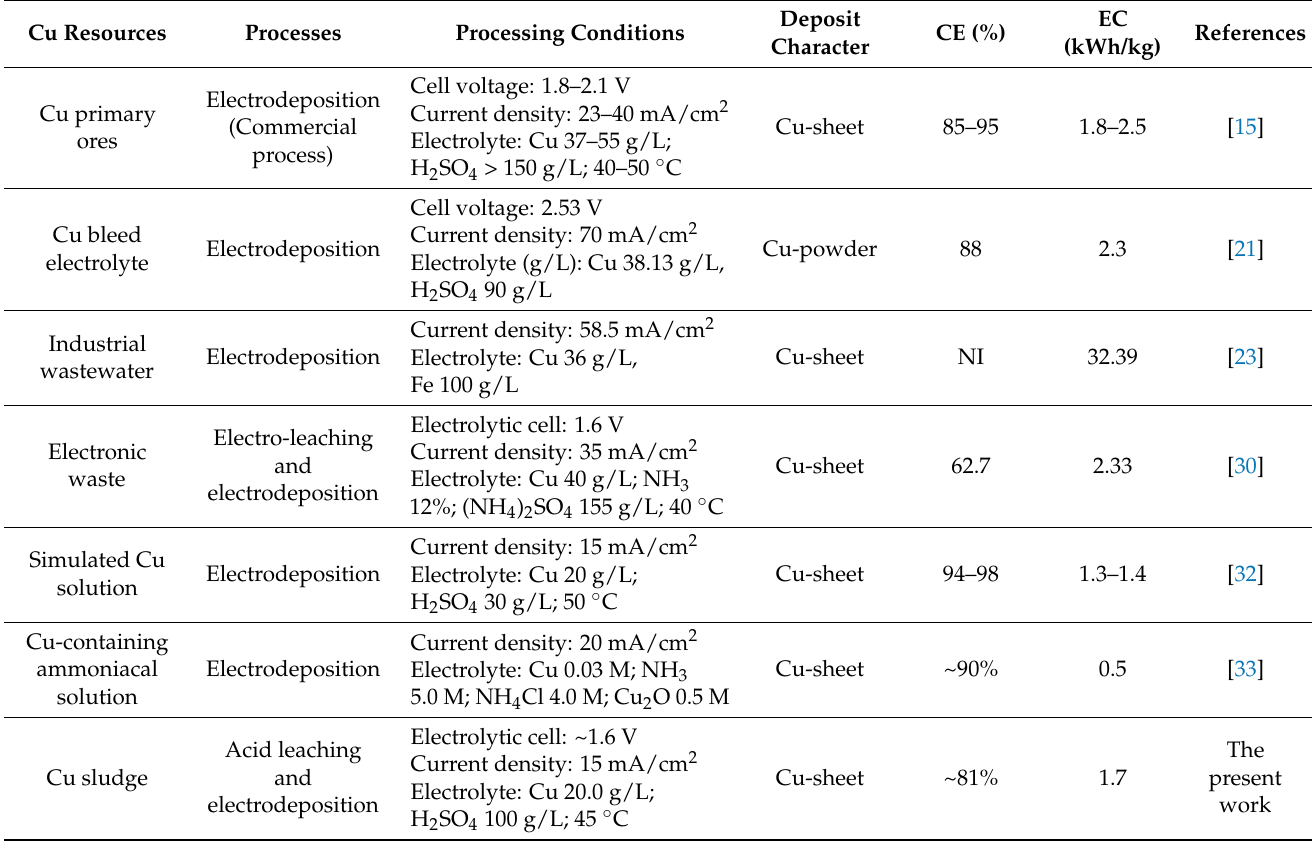
Table 2. Comparison of current efficiency and energy consumption of Cu electrodeposition from different resources and processes.